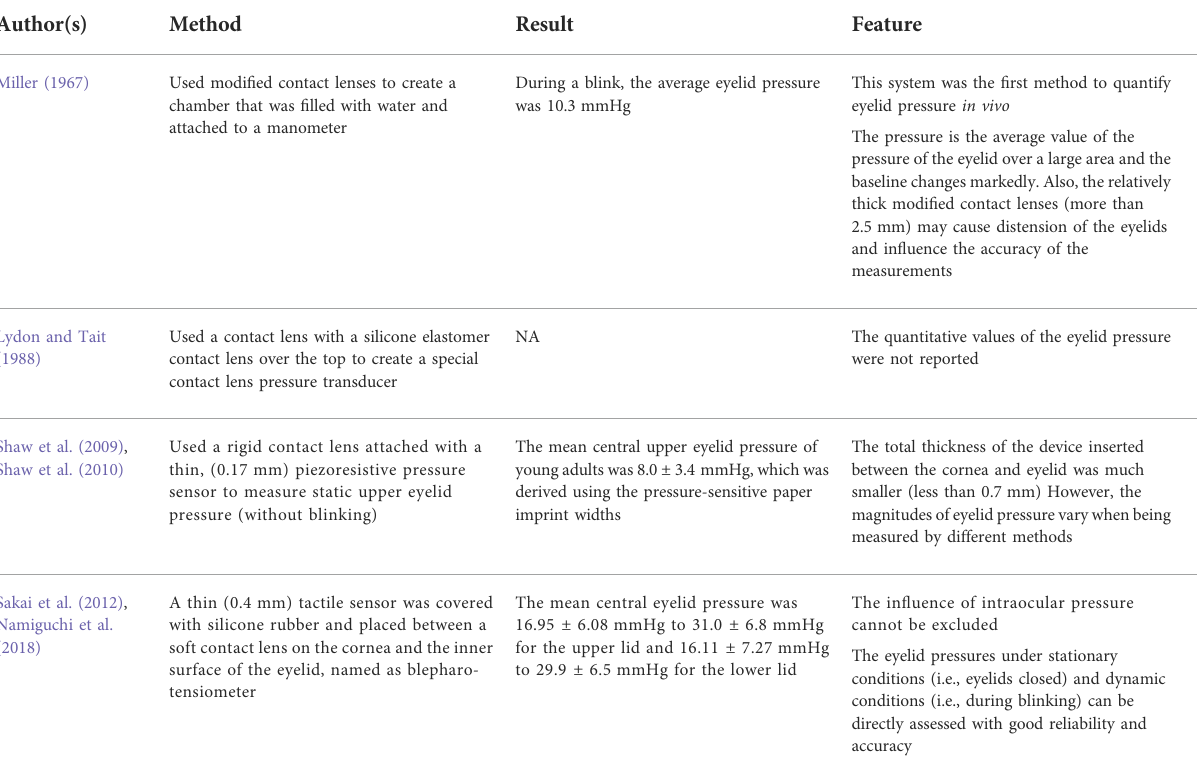
respectively. Moreover, shear stress in the standing orientation with a greater temperature difference